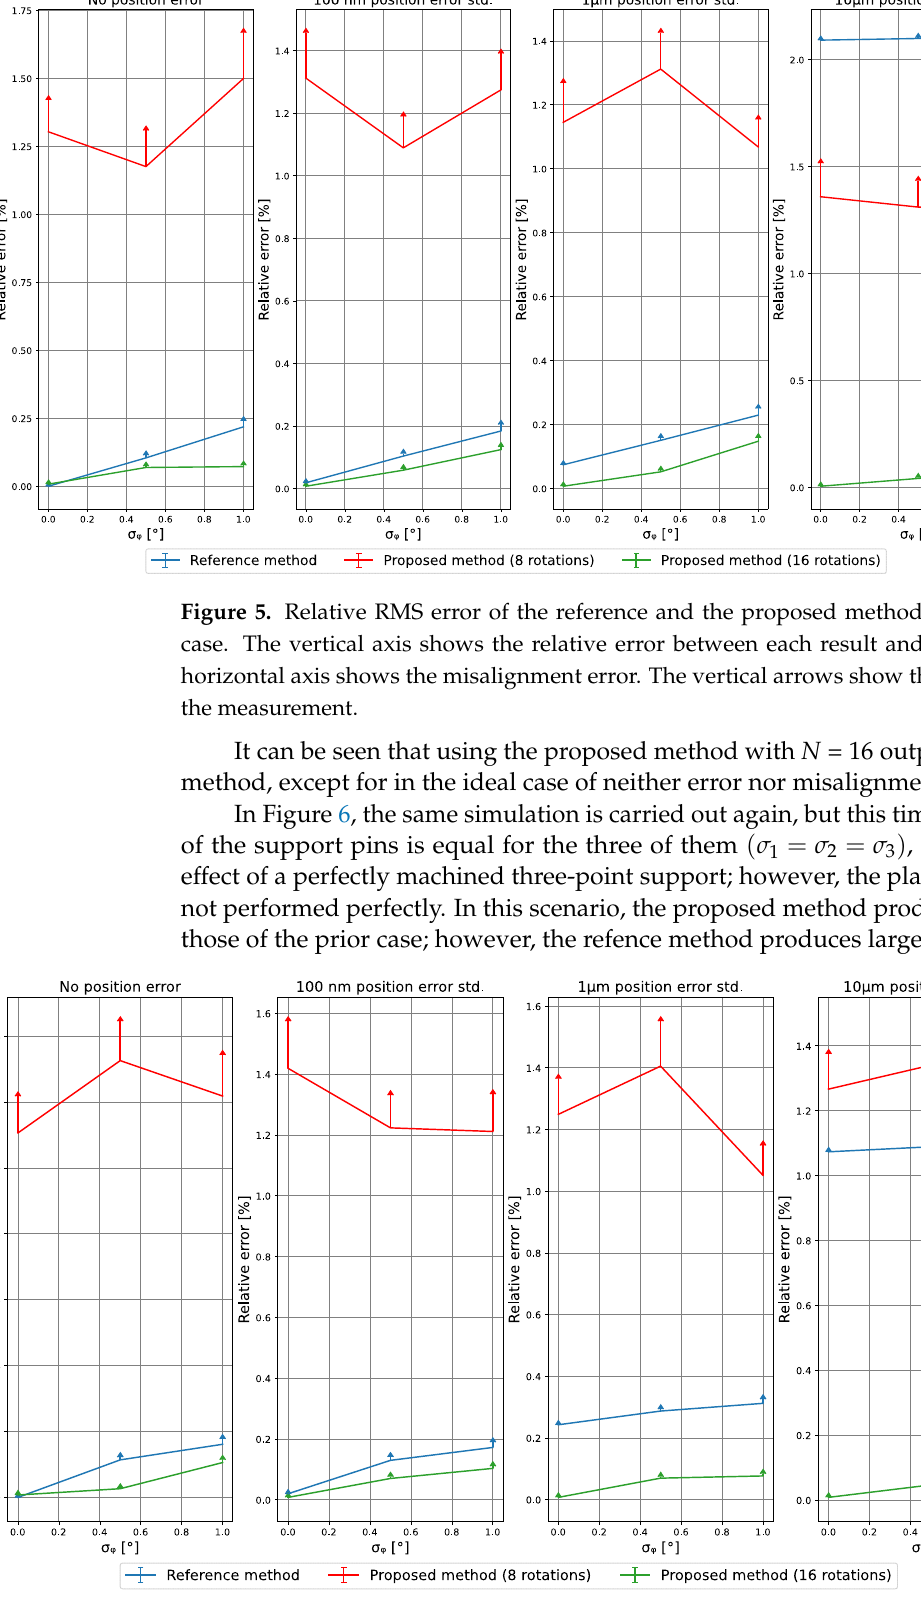
Figure 6. Relative RMS error of the reference and the proposed methods for equal error case. The vertical axis shows the relative error between each result and the ground truth. The horizontal axis shows the misalignment error. The vertical arrows show the standard deviation of the measure- ment.